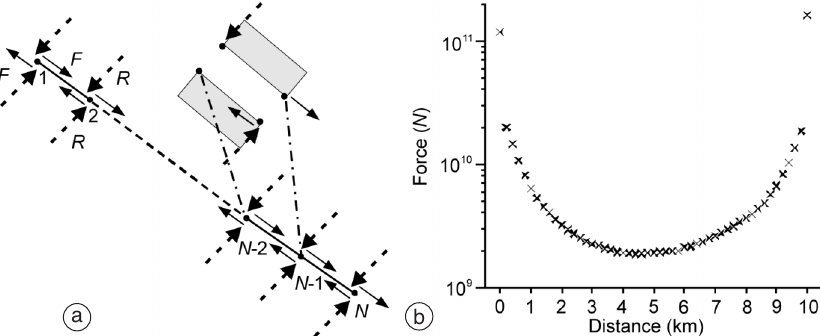
Fig. 2a,b. a) Sketch of the force couples ( F , continuous-line arrows) and the reaction forces ( R , dashed arrows) applied to N nodes along the fault (line); each filled circle represents two opposing nodes on either side of the fault, falsely separated in the enlarged outline, where the gray shades represent the elements. b) Magnitude of the force ( F ) versus down-dip distance, in the case of 1 m uniform